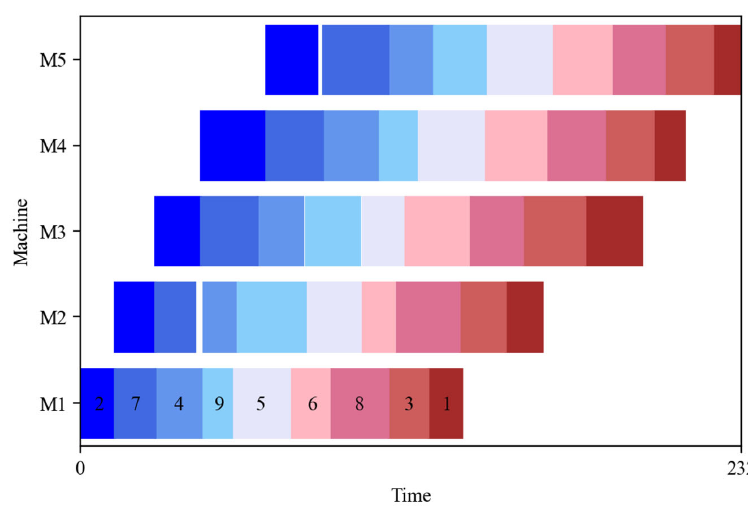
Figure 5. Gantt chart of the optimal solution.